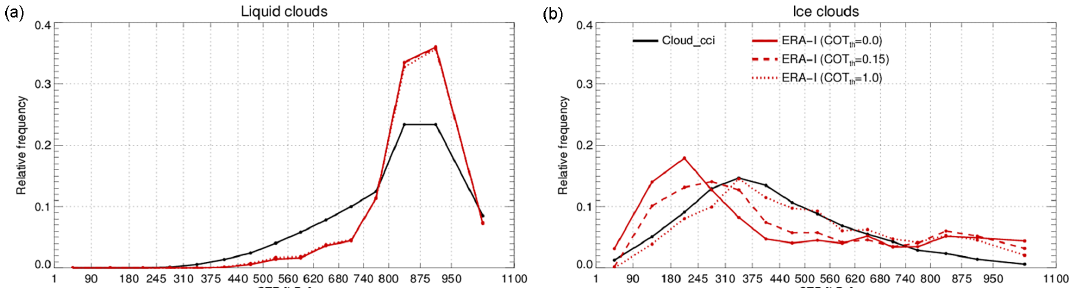
Figure 5. Global, multi-annual relative frequency histograms of observed Cloud_cci cloud-top pressure (CTP) compared to ERA-Interim CTP after applying SIMFERA with three COT thresholds (0.0, 0.15 and 1.00) – separated in liquid (a) and ice clouds (b)